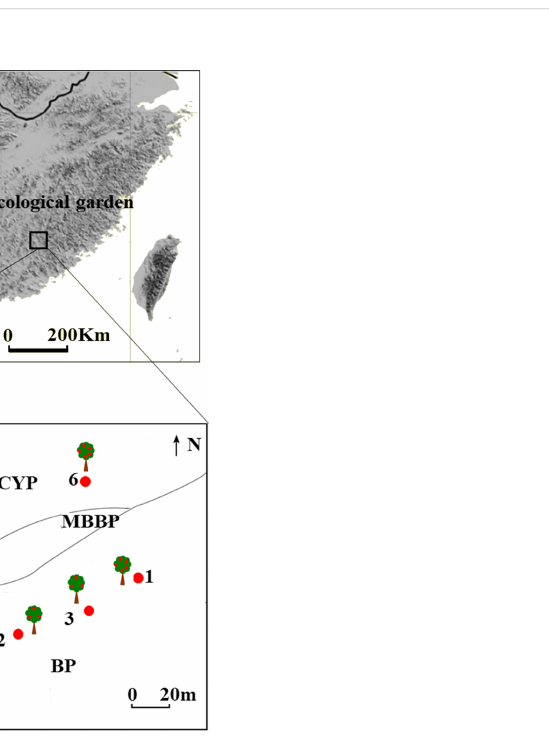
FIGURE 1 Study site and distribution of mother tree in different patches in yew ecological garden, Fujian province, southeast China. CYP, Evergreen broad-leaved forest patch; MBBP, Mixed bamboo and broad-leaved patch; BP, Bamboo patch; FP, Farmland patch. Red dots in the trees represent the fruit amount, 1 dot represent seeds < 15,000; 3 dots represent 15,000 < seeds < 20,000; 5 dots represent seeds >